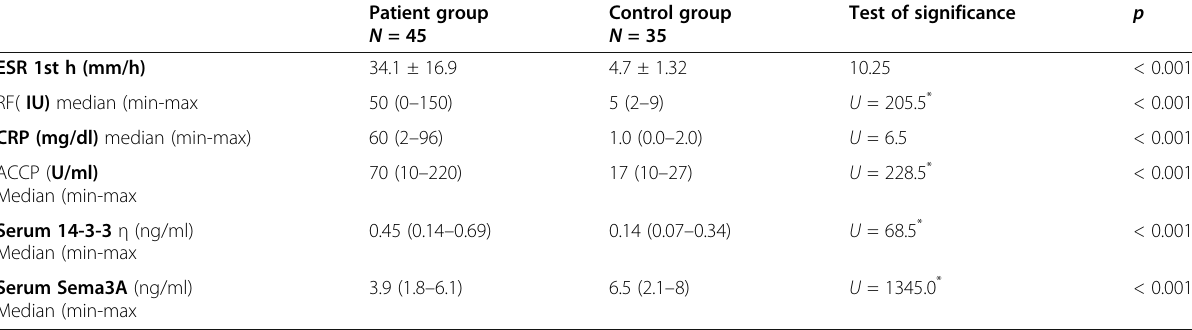
Table 1 Comparison between the two studied groups according to different clinical and laboratory